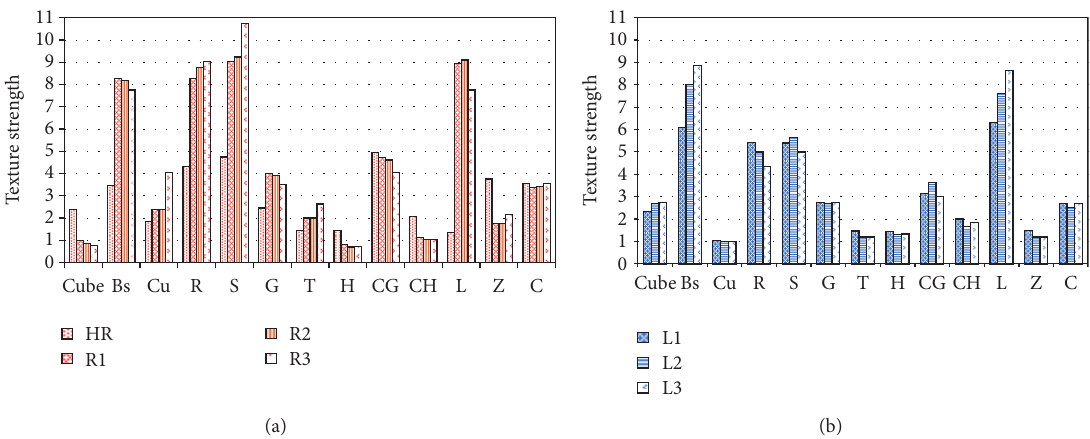
Figure 5: (a) Texture strength of ideal texture components after final cold rolling. (b) Texture strength of ideal texture components after final annealing.